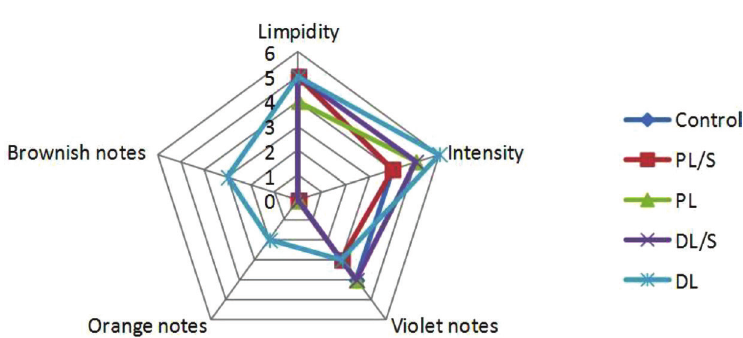
Fig. 4 – Visual aspect of control sample: sulfurized wine in the first year of maturation (PL/S), unsulfurized wine in the first year of maturation (PL), sulfurized wine in the second year of maturation (DL/S), and unsulfurized wine in the first year of maturation (DL)